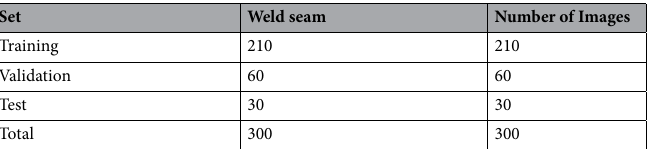
Table 2. Composition of dataset for training, validation, and test, including assignment of classes and number of images per class.